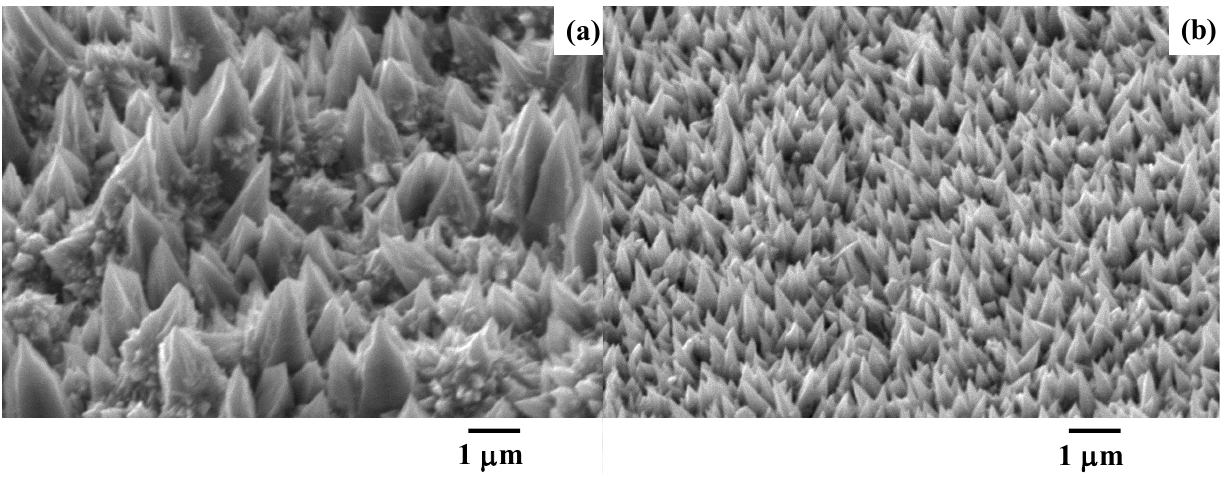
Figure 7. SEM image on the two types of acicular microtextures on the copper plate formed by the wet-plating. ( a ) Coarse acicular microtextures (LL-specimen) and ( b ) fine acicular microtextures (SS-specimen).